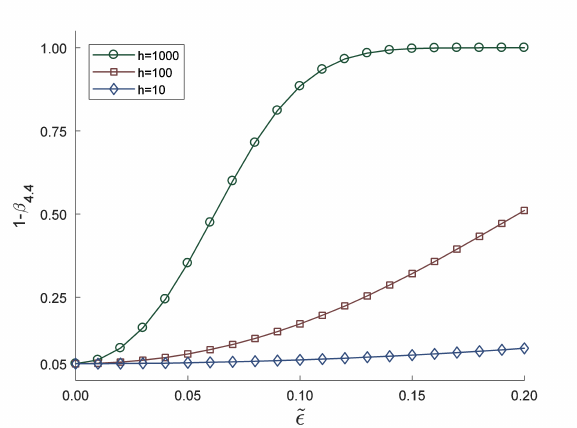
Figure 3: Power functions for T 4.4 and various values of h.